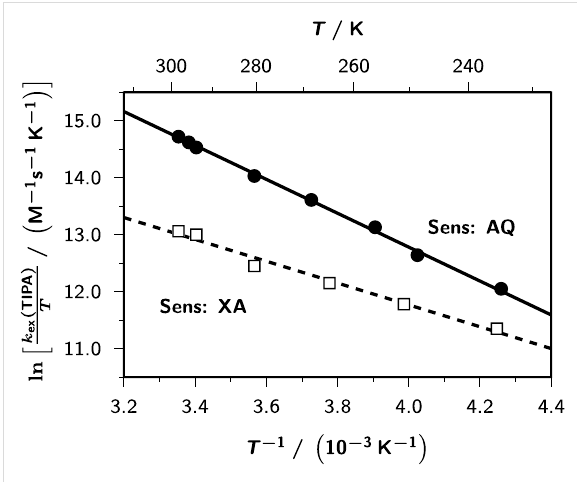
Figure 4: Eyring plots for the self-exchange rate constants k ex (TIPA) of triisopropylamine (TIPA) sensitized by anthraquinone (AQ) (full circles and solid line; linear regression, 24 . 68 − 2975/ T ) and xanthone (XA) (open circles and broken line; linear regression, 19 . 43 − 1917/ T ). All experimental parameters, expect for the temperature T , as in Figure 3. Further explanation, see text.